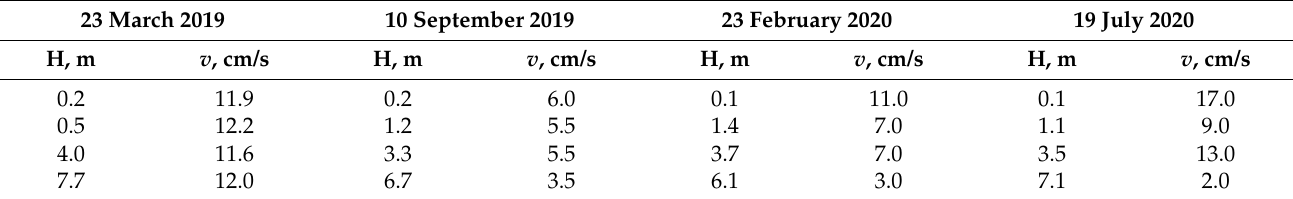
Table 1. The current velocity in the section of the grotto (station 6) at different depths.